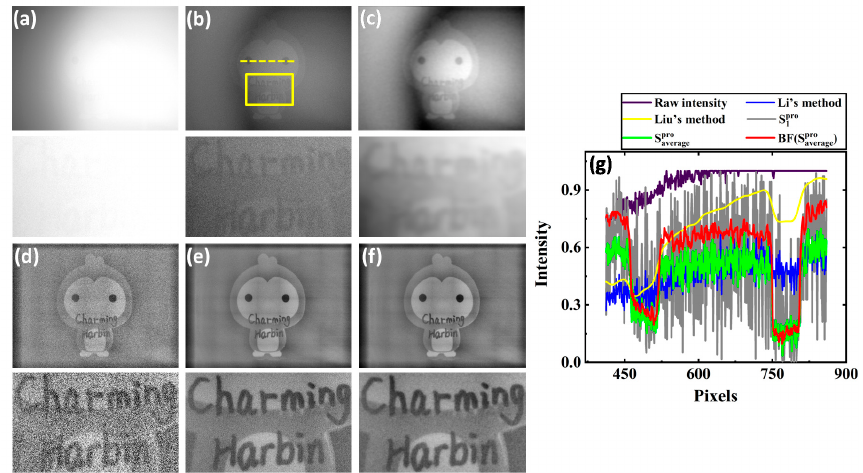
Figure 8. ( a ) is the raw image intensity; ( b ) the result of using Li’s method [25];( c ) the result of using Liu’s method [32];( d ) is ; ( g ) the pixel grayscale index curves of the raw image intensity and the processing re- sults of different